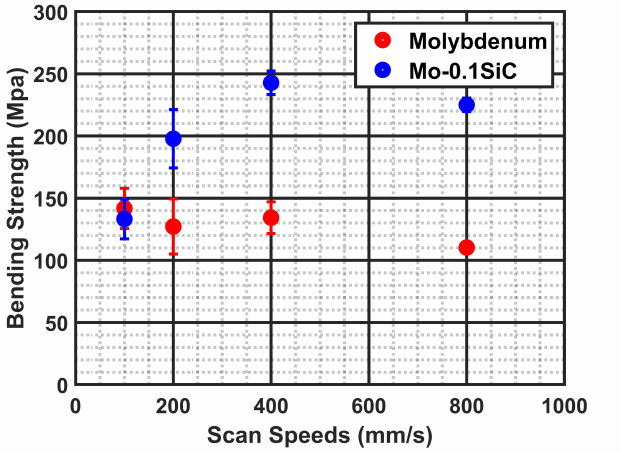
Figure 8. Flexural strength of the prepared pure molybdenum and Mo-0.1SiC specimens at the four different scan speeds. The error bars represent the standard deviation of the three measurements taken for each scan